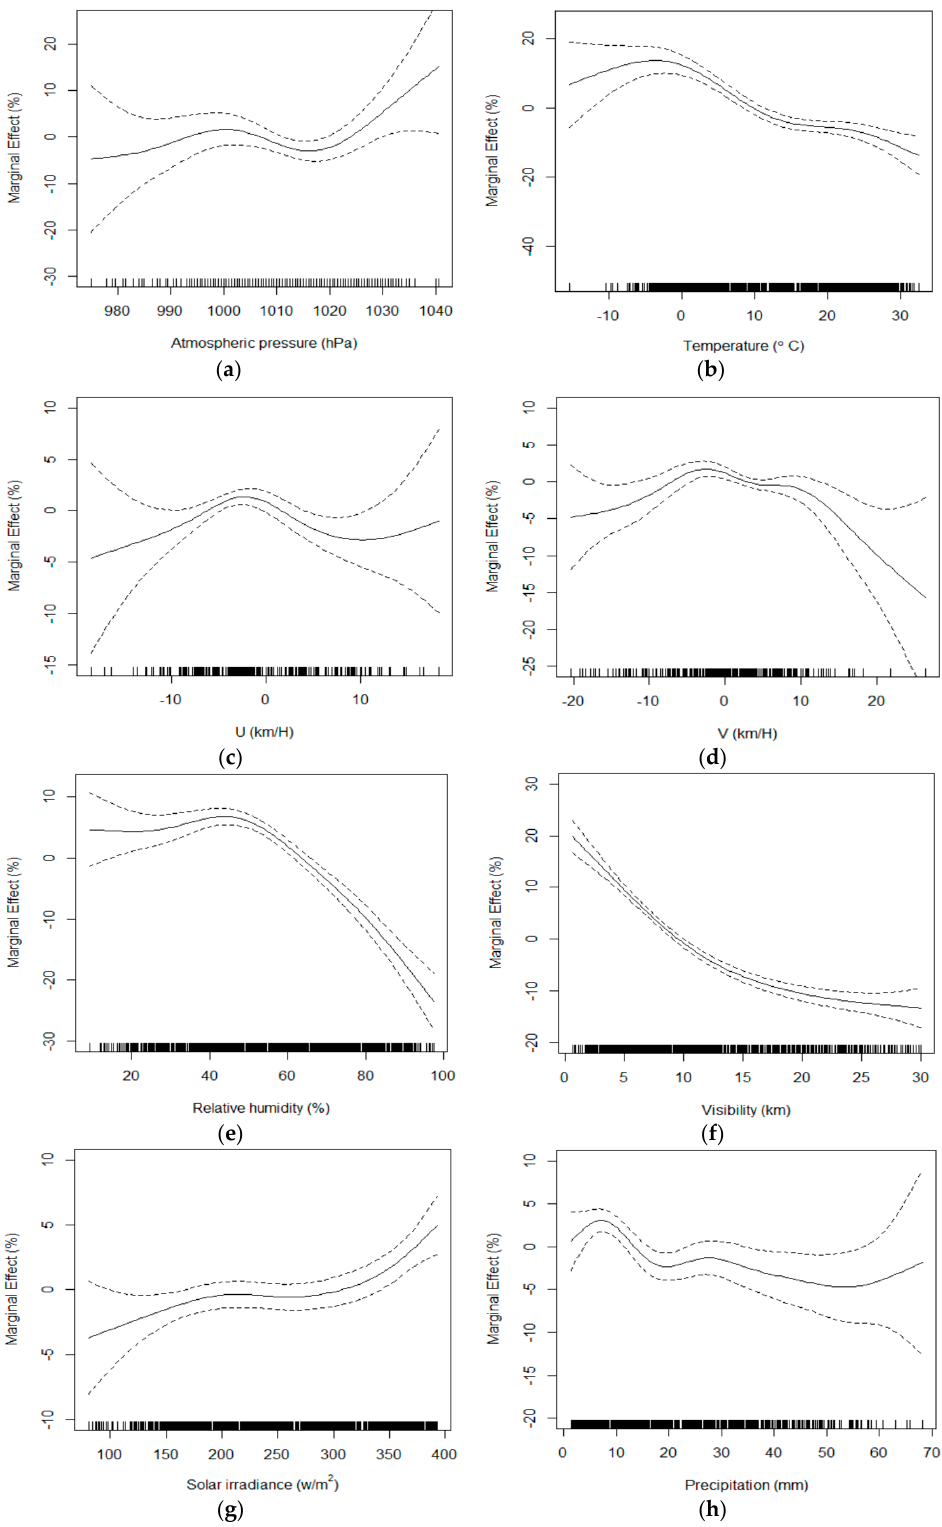
Figure 3. Partial residual plot for SO 2 . ( a ) atmospheric pressure; ( b ) temperature; ( c ) zonal ( u ) wind; ( d ) meridional ( v ) wind; ( e ) relative humidity; ( f ) visibility; ( g ) solar irradiance; ( h ) precipitation. The abscissa represents the magnitude of each meteorological variable. The ordinate represents the marginal effect, which is the impact of various meteorological variables on air pollutants. The dashed line is the 95% confidence interval and the short line perpendicular to the abscissa represents the distribution frequency of each meteorological variable.